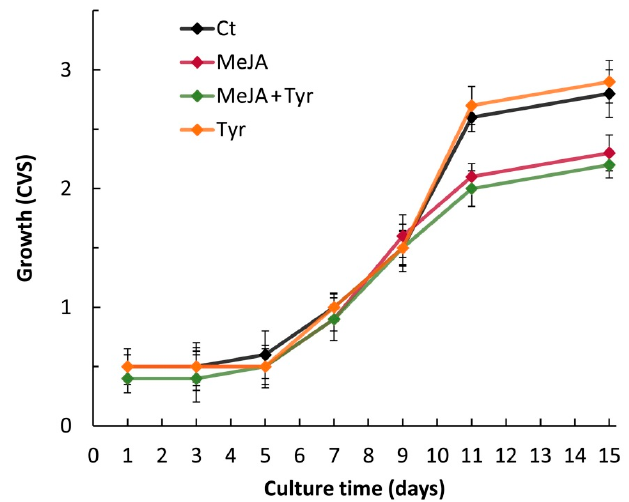
Figure 1. Growth curve of hemp cell suspensions (var. Futura) not elicited (Control, Ct), elicited with methyl jasmonate (MeJA), MeJA + tyrosine (MeJA + Tyr), or treated with tyrosine (Tyr). CVS: